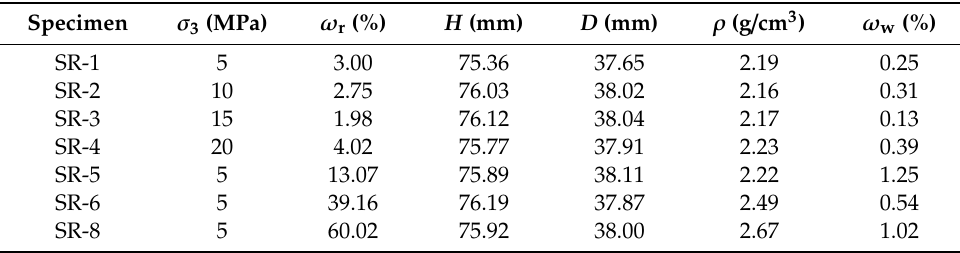
Table 2. Salt rock specimens in this experiment.